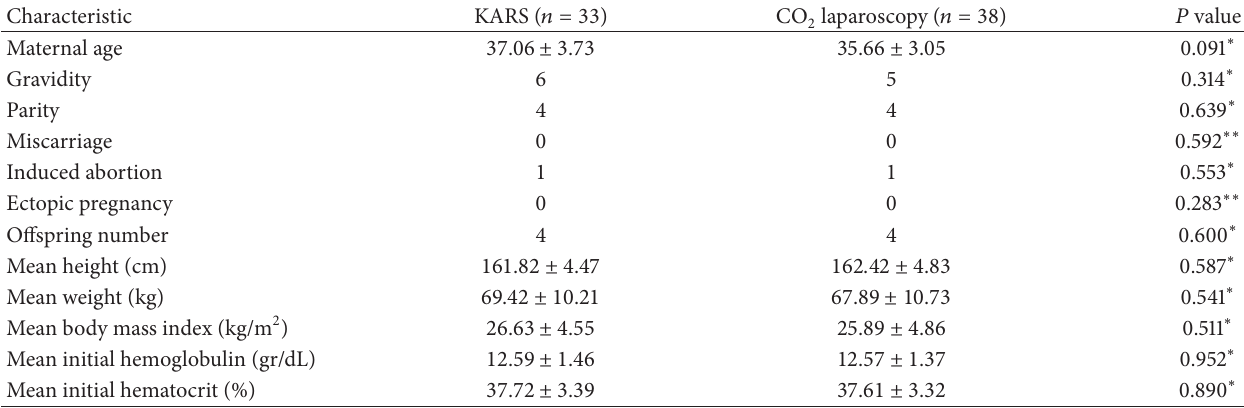
Table 1: The demographics, physical characteristics, and the preoperative findings of the participating women in both groups. The data was presented with mean ± standard deviation or median values.